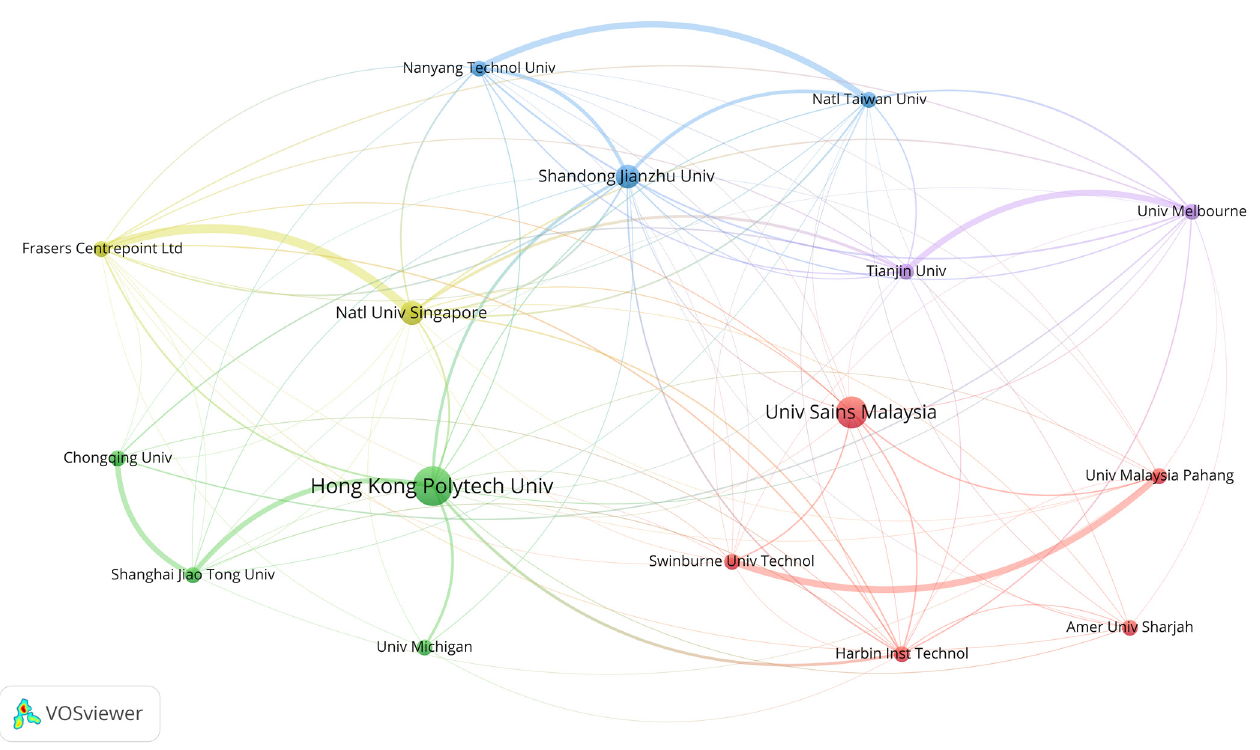
Figure 6. Map of global collaboration network among institutions.